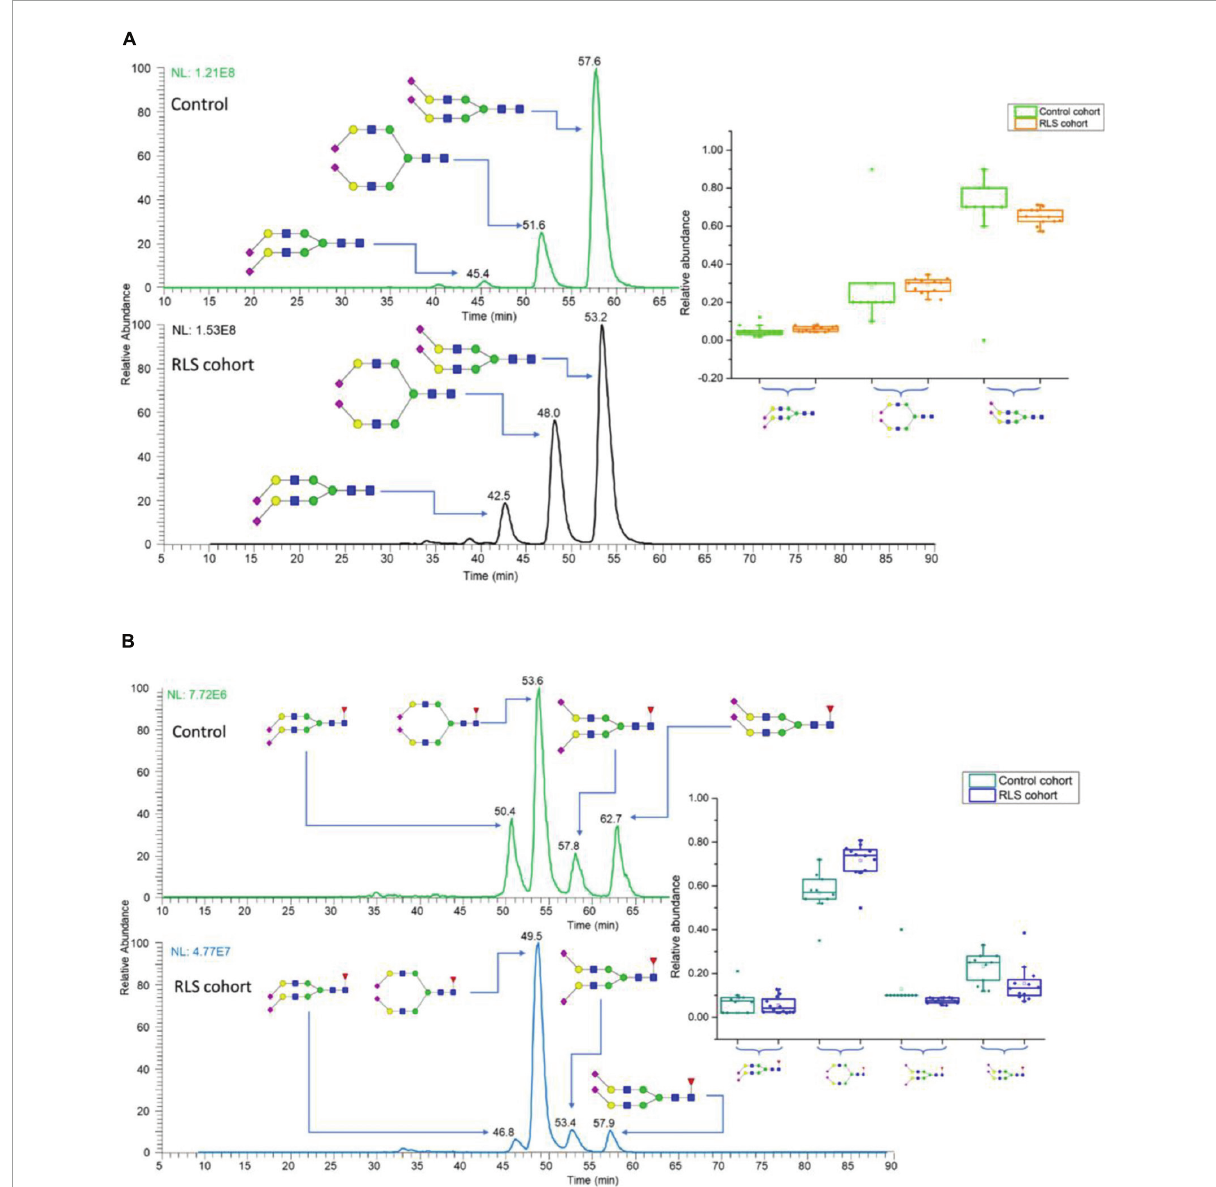
FIGURE5 EICs of N-glycan isomers with different linkages in control and restless legs syndrome (RLS) cohorts, separated on PGC (A) disialylated linkage isomers, (B) disialylated linkage isomers with core fucose connections. Insets are the box plots showing the distributions of disialylated isomers among 10 studied subjects in the control and 12 subjects in the RLS cohorts. The box stands for the first quartile and third quartile; the line represents median; and the whiskers above and below the box set the limits for outliers. Reprinted with the permission from Dong et al.